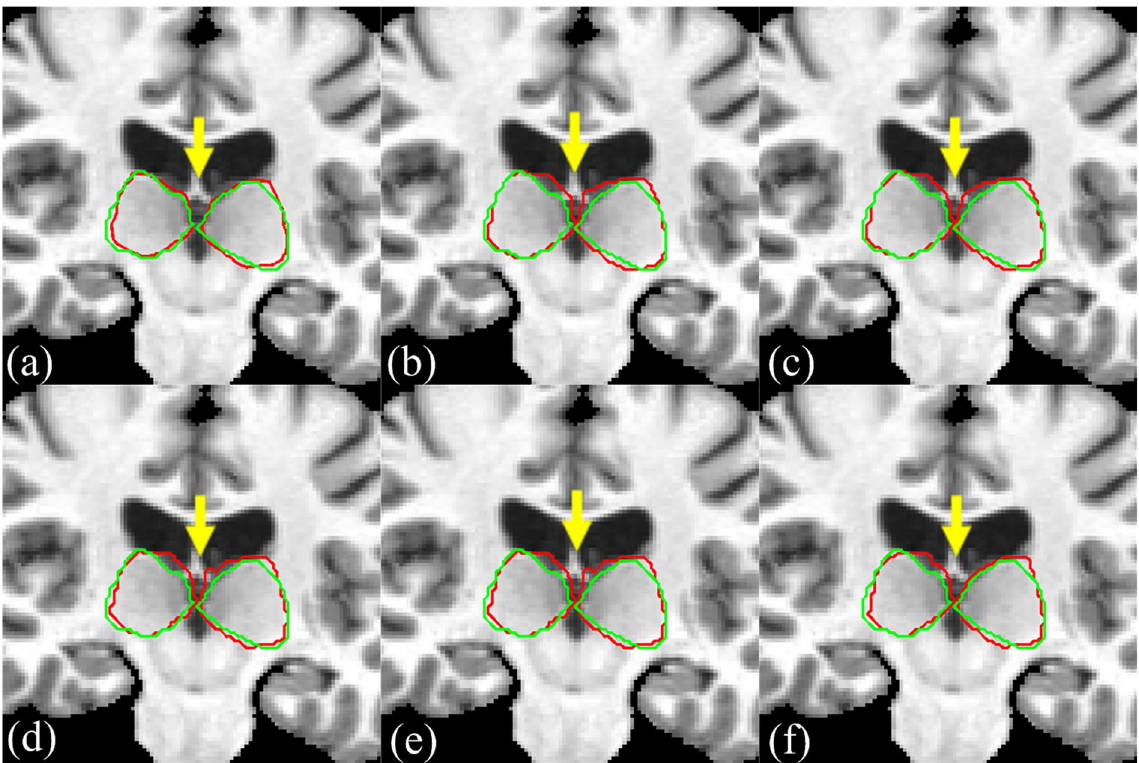
Figure 8. The segmentation results of MICCAI image No. 1025 by our method and five other methods. ( a ) Our method, ( b ) STAPLE, ( c ) Spatial STAPLE, ( d ) Major Voting, ( e ) Weight Voting, ( f ) SIMPLE. Automatic segmentation results are illustrated in red contour, the manually-delineated thalamus boundary shown by the green